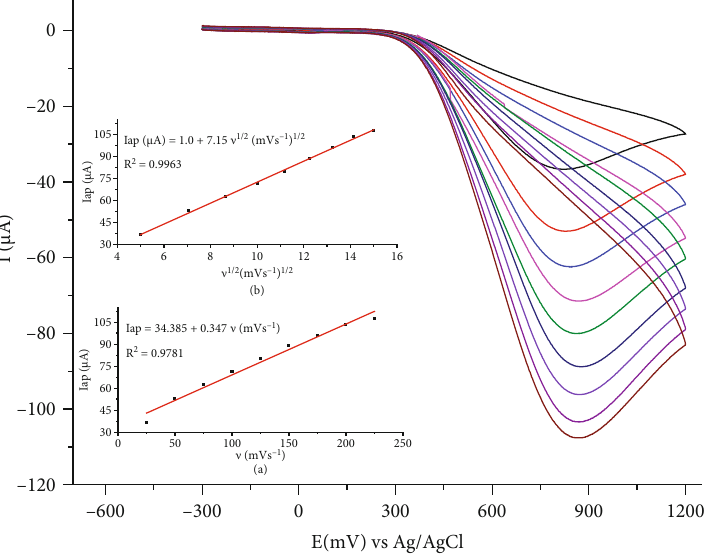
Figure 3: Cyclic voltammograms of AQMCPE in pH 4 PBS containing 2 mM AA at various scan rates (a – i: 25, 50, 75, 100, 125, 150, 175, 200, and 225mVs -1 , respectively). Inset: plot of anodic peak current vs. (a) scan rate and (b) square root of scan